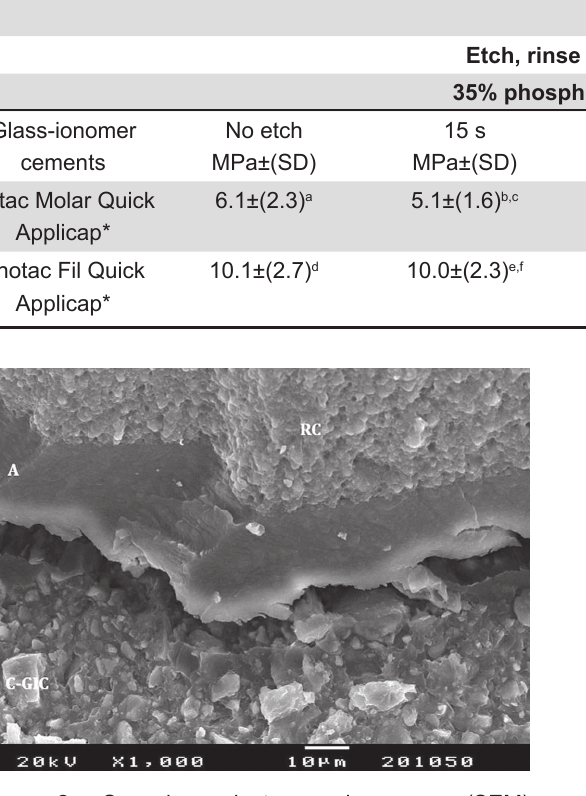
Figure 2- Scanning electron microscopy (SEM) evaluation indicated cracks in certain areas of bonding between adhesive and conventional glass-ionomer cement (C-GIC). RC= composite